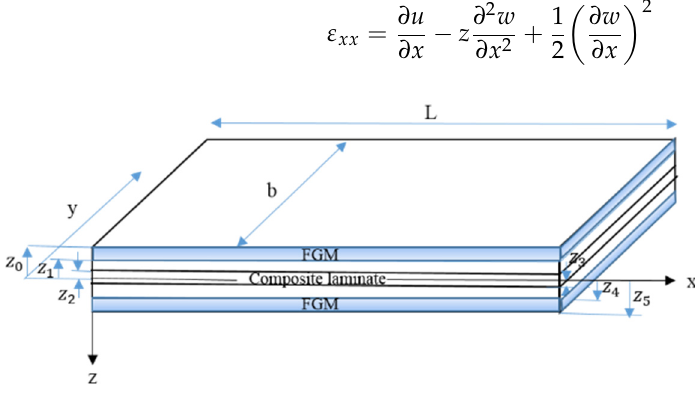
Figure 1. FG-Fiber-Reinforced Composite Laminated